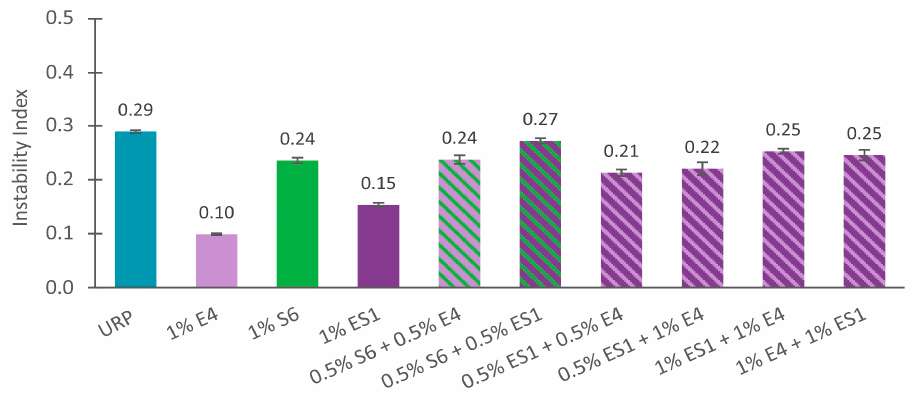
Figure 5. Instability index of URP with different combinations of dispersing agents and comparison with the dispersing agents added individually (6 h at 300 × g ). Refer to Tables 1–4 for dispersing agent labels. Error bars depict sampling error. Values are significantly different from the control URP ( p < 0.0001).